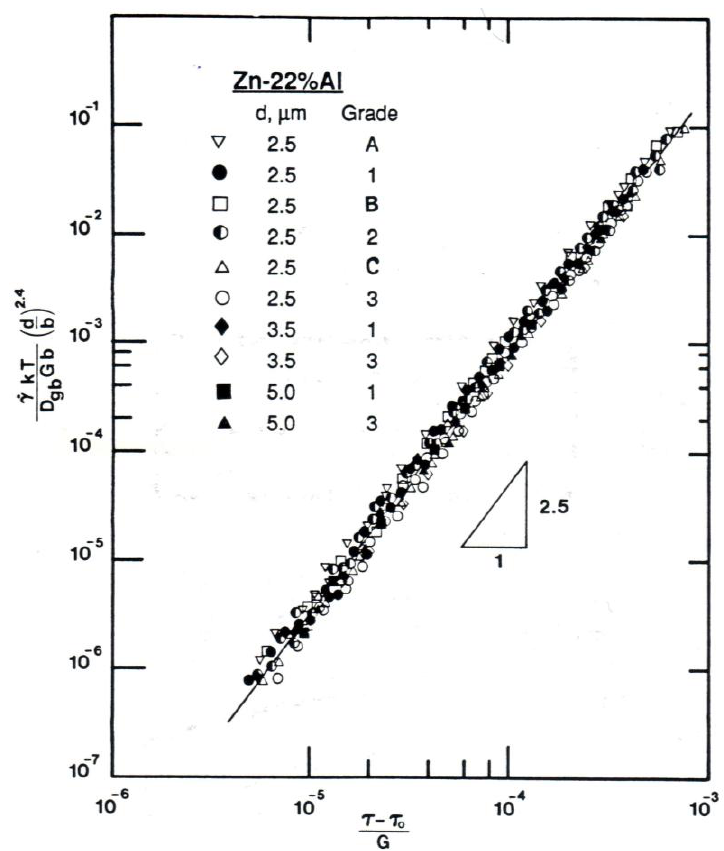
Figure 6. A plot of normalized creep rate vs. normalized effective stress for several grades of Zn-22% Al containing different impurity levels. Data were taken from